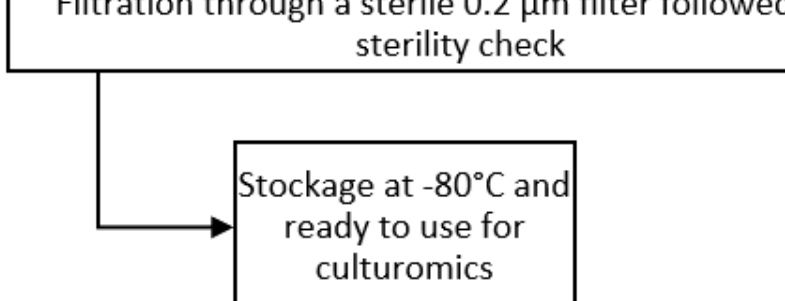
Figure 8. Workflow we used for sterilizing the rumen fluid. No autoclave was used in order to preserve the thermolabile components. Sterility was checked at the end of the